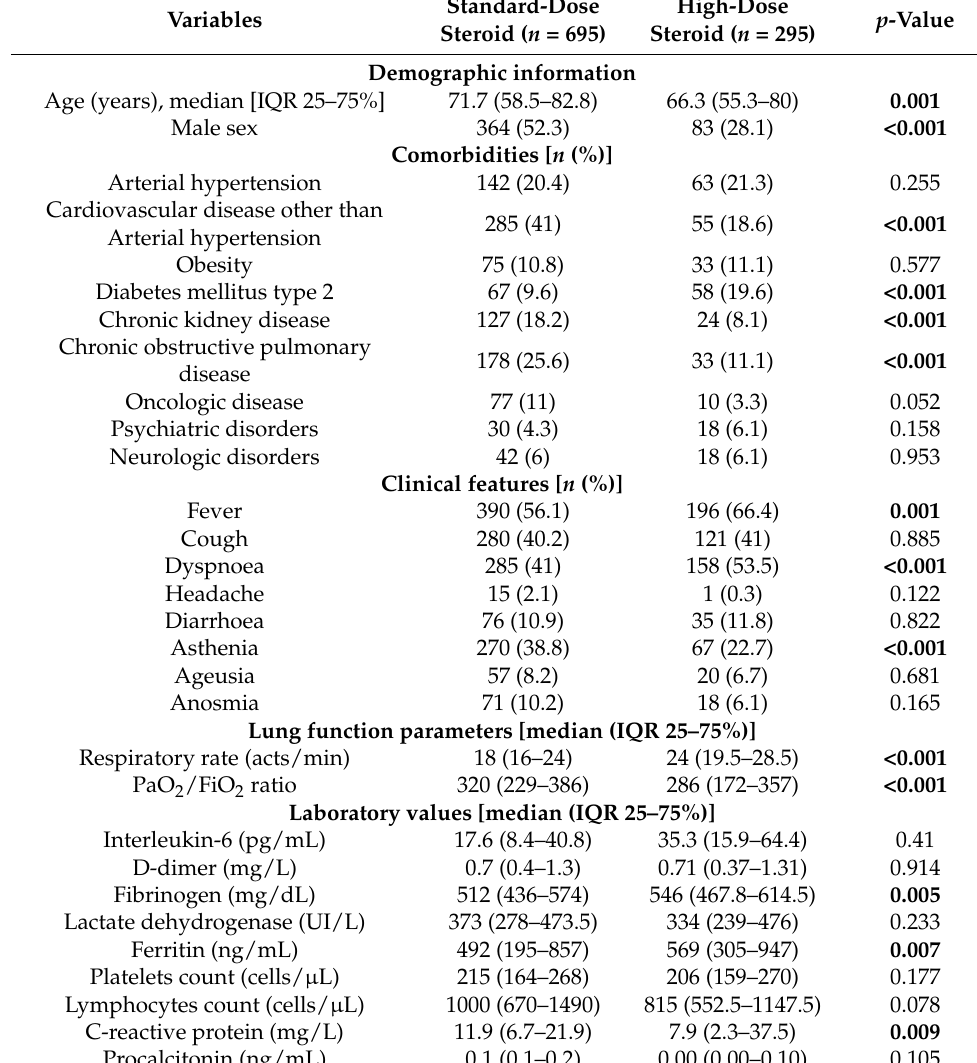
Table 2. Comparison between COVID-19 patients treated with standard- or high-dose steroids.